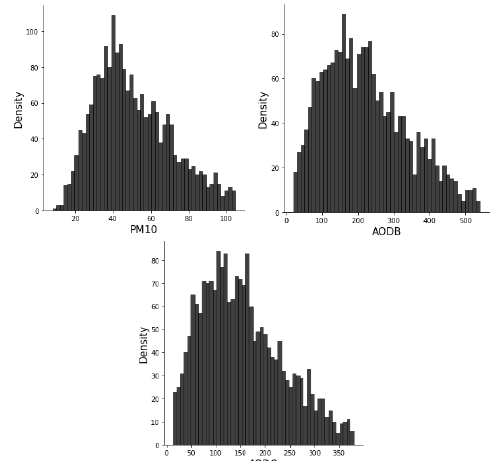
Figure 6. Histogram of the input parameters for PM 10 models.